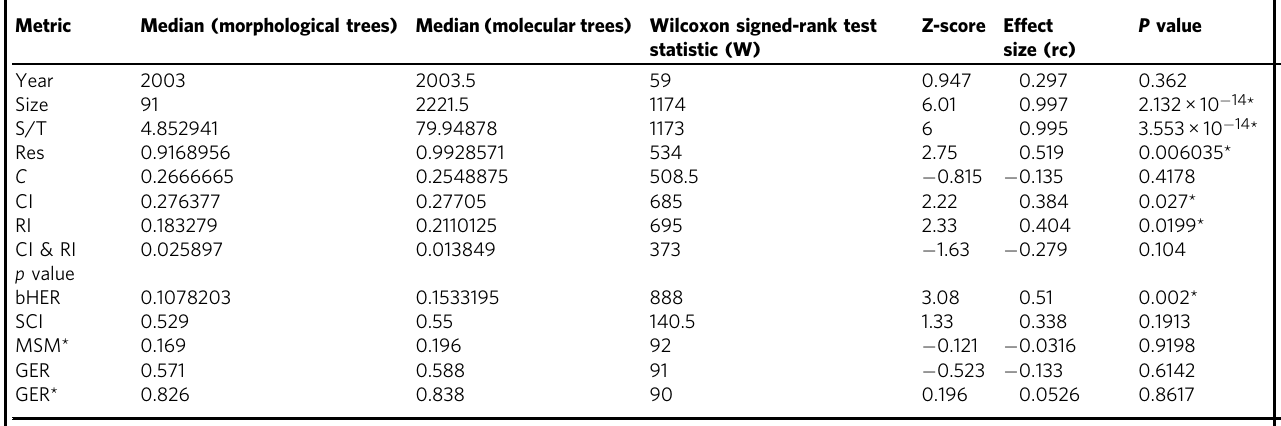
Table 1 Biogeographic and stratigraphic congruence of morphological and molecular phylogenies. Metric